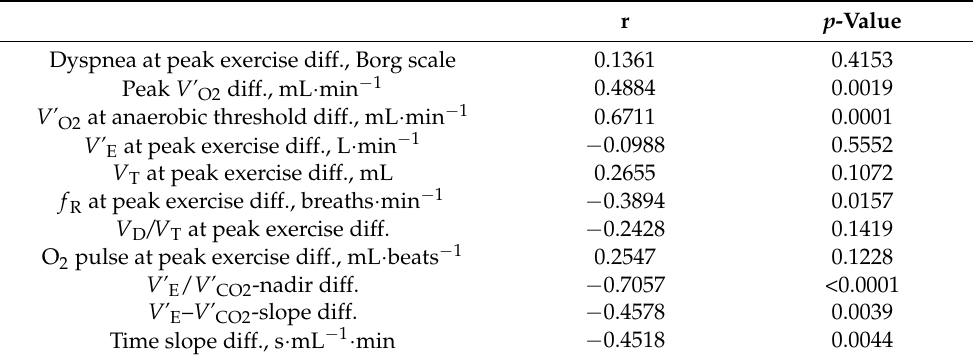
Table 6. Correlations between the change in the ∆ FO 2 at peak exercise resulting from pulmonary rehabilitation and other parameters ( n = 38). r p -Value Dyspnea at peak exercise diff., Borg scale 0.1361